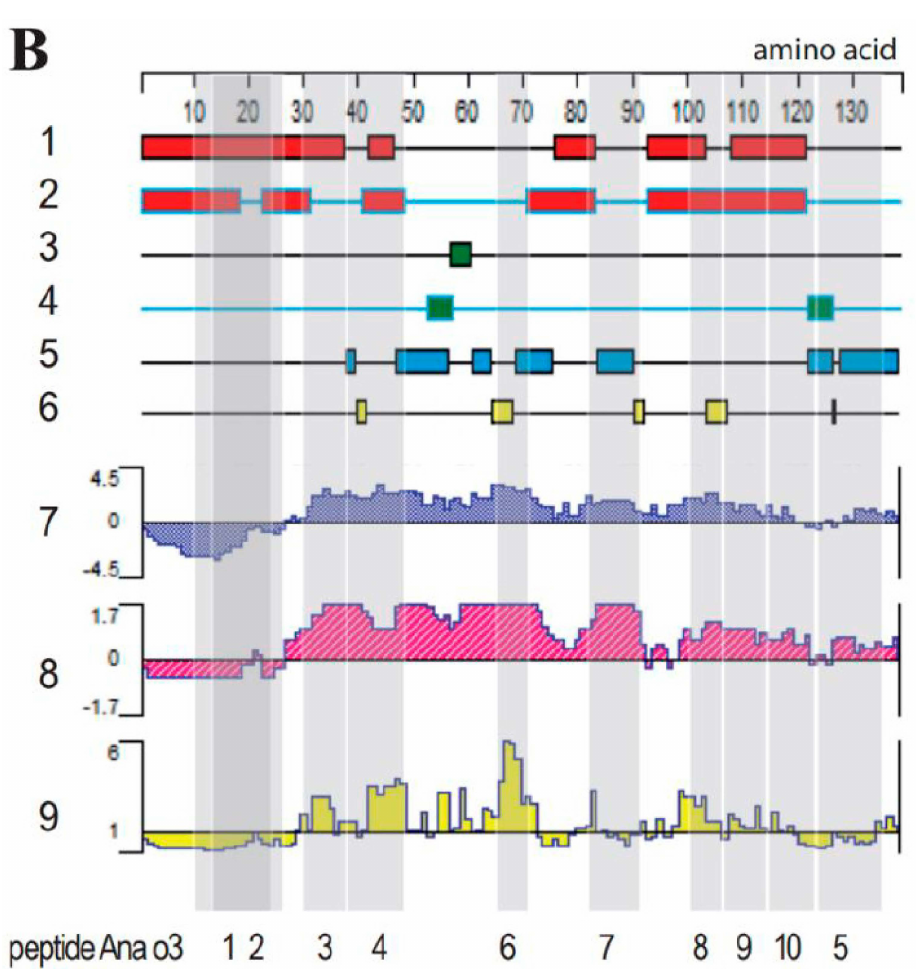
Figure 2. Bioinformatic analysis of the Ana o 2 ( A ) and Ana o 3 ( B ) features. Lanes 1–6: secondary structure analysis revealing alpha regions by using the Garnier–Robson (1) and Chou–Fasman methods (2), beta regions by using the Garnier–Robson (3) and Chou–Fasman methods (4), turn regions by using the Garnier–Robson method (5), and coil regions by using the Garnier–Robson method (6). Further lanes reveal hydrophilicity by using the Kyte–Doolittle method (7), the antigenic index by using the Jameson–Wolf method (8), and the surface probability by using the Emini method (9). Grey shading in both panels corresponds to the produced peptides, whose names are listed below the